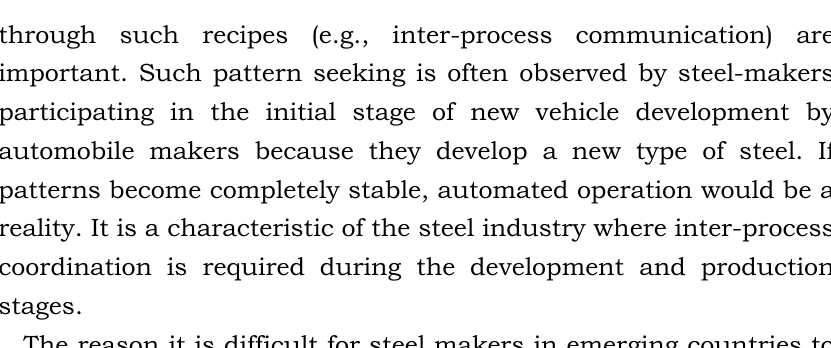
Figure 2. Selecting and combining operational parameters